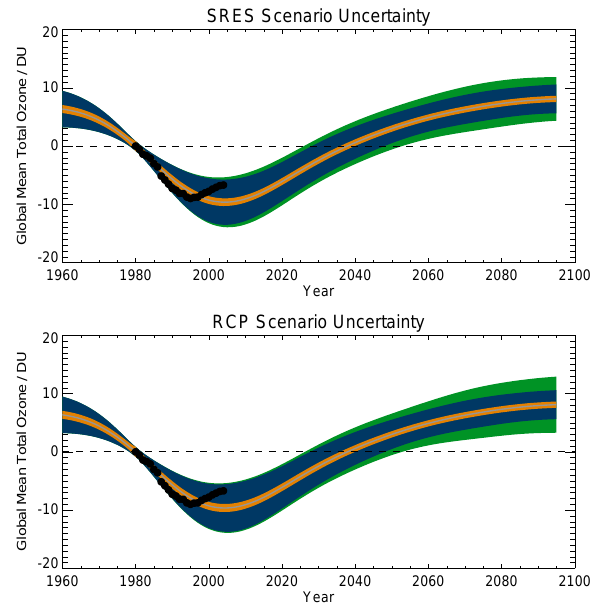
Fig. 2. Changes in annual-mean, global-mean, total-column ozone amounts relative to 1980 values. Black dots indicate observed changes from the NIWA combined and patched ozone column dataset. The grey solid line shows the multi-model, multi-scenario mean. Coloured wedges indicate the cumulative uncertainty in this projection associated with one standard-deviation estimates of internal variability (orange), model uncertainty (blue) and scenario uncertainty (green). The top panel shows calculations of scenario uncertainty using four model simulations run with SRES scenarios. The bottom panel shows calculations of scenario uncertainty using three integrations of CAM3.5 run with RCP scenarios.